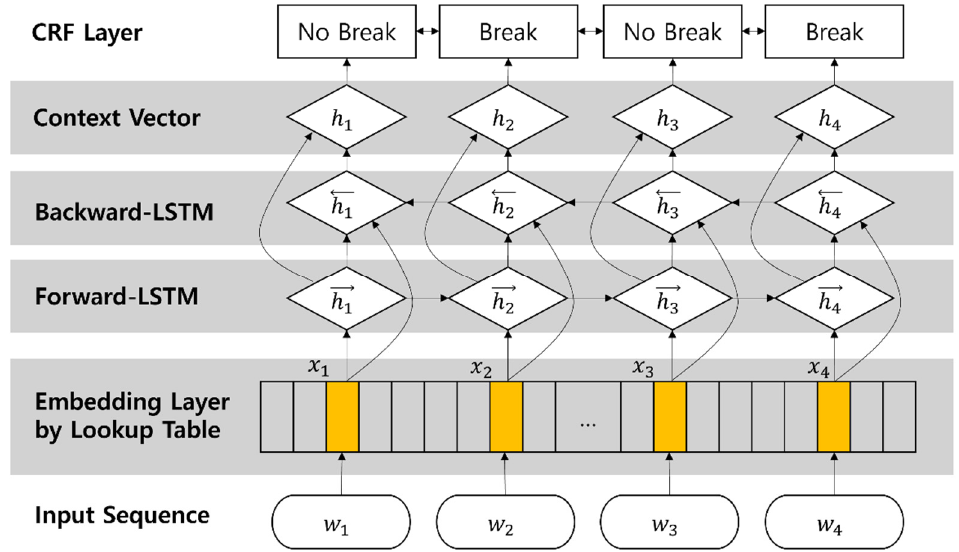
Figure 4. Structure of BLSTM-CRF modeling.